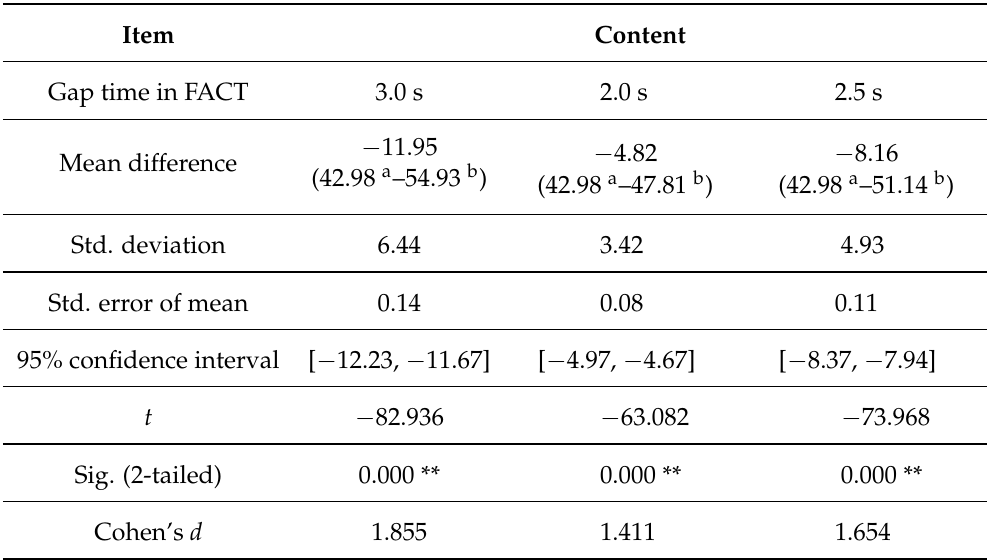
Table 3. Paired samples t -test on the average vehicle delay at the TA-enabled and FACT-enabled intersections with different gap